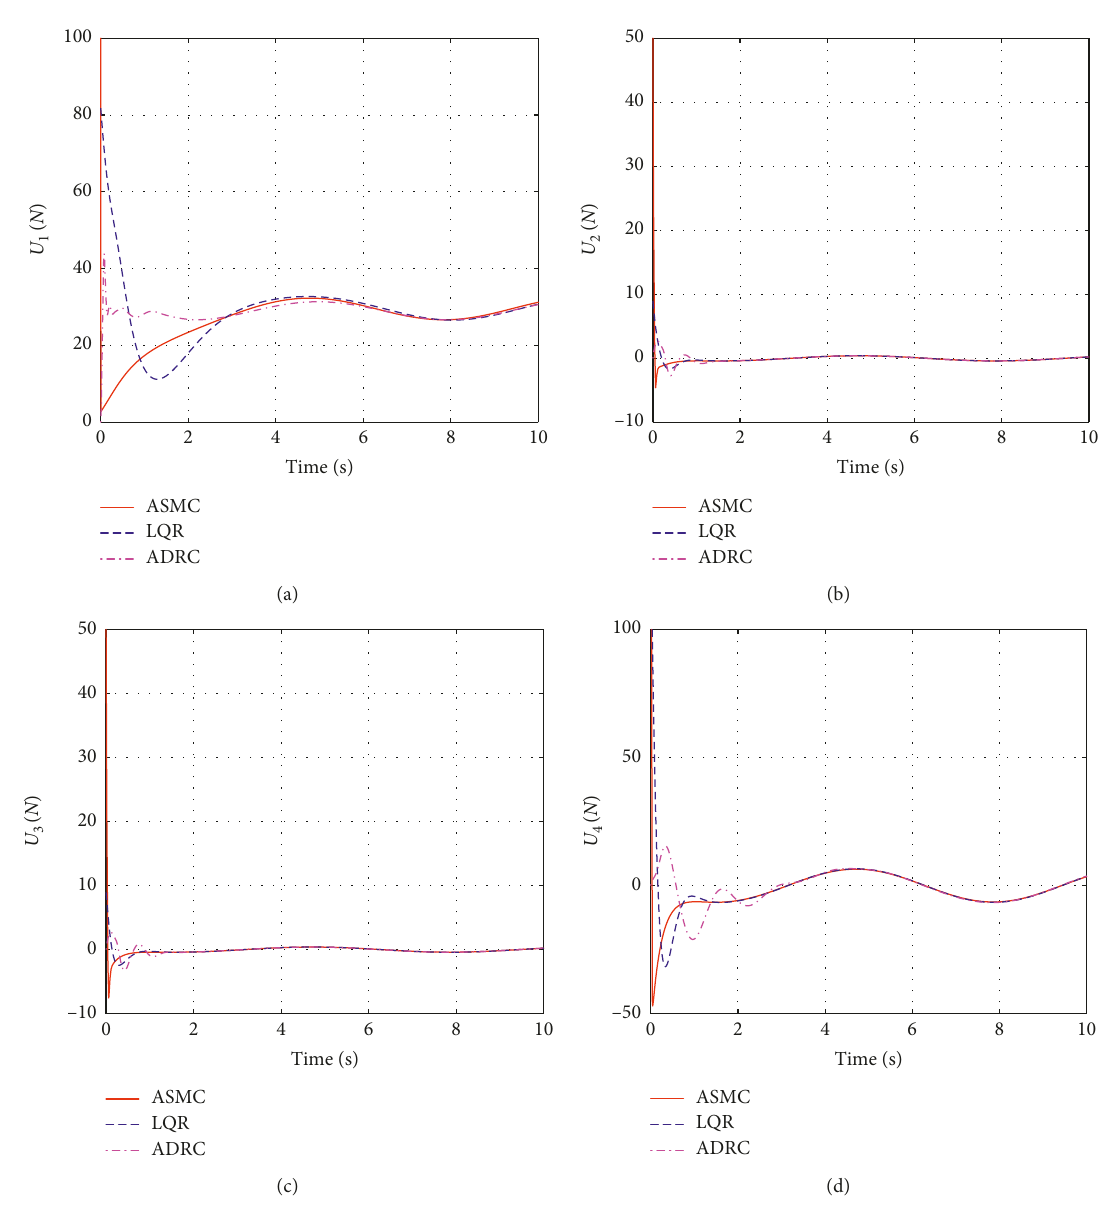
Figure 5: The control input profiles for all the input